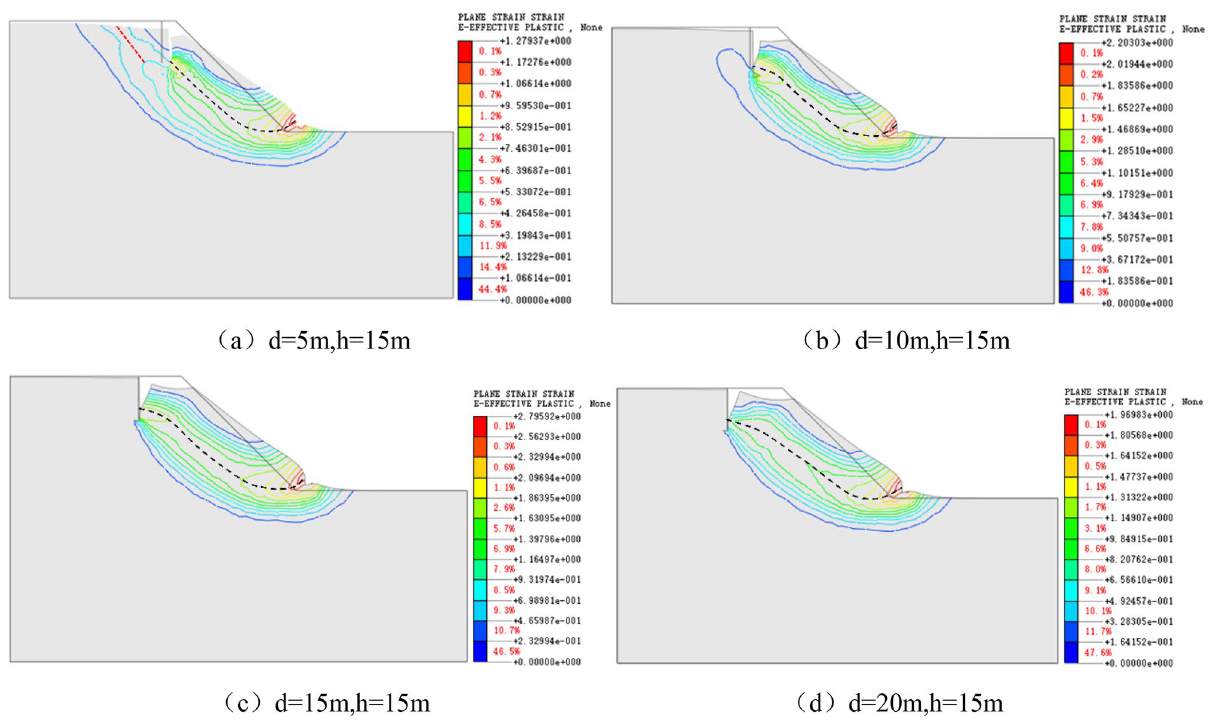
Figure 7. Cloud chart of the plastic zone and sliding surface with vertical joints h = 15 m and d = 5–20 As displayed in Fig. 6, firstly, the cloud chart with the contour line of the plastic zone at the bottom of the vertical joints are denser, which indicates that the stress concentration phenomenon occurs here and the actual slope is subjected to more considerable tensile stresses; secondly, the failure surface of the slope consists of two parts, the tensile zone at the top of the slope (red dashed line) and the tensile zone at the bottom of vertical joints + shear zone at the bottom of vertical joints (black dashed line); thirdly, with the increase of the length of vertical joints, the influence of vertical joints on the overall sliding surface of the slope gradually improves. When the length of vertical joints is h = 5 m, the sliding surface of the slope is similar to the pure slope model without joints, and the sliding surface does not pass through the bottom of vertical joints. When the length of vertical joints is h = 10–15 m, the failure of the slope starts from the bottom of vertical joints to shear out at the foot of the slope. When the length of vertical joints is h = 20 m, the sliding surface of the slope no longer starts from the bottom of the vertical joints but from the middle and lower part of the vertical joints, which is consistent with the failure results of the soil mechanical experiments (Fig. 4), indicating that there is an extreme value of the influence of the length of vertical joints on the sliding surface. The stress concentration at the bottom of vertical joints reaches the peak when the length of the vertical joint h = 5 m. So the length of the vertical joint h = 15 m has the most significant influence on the stability of the slope, which is identical to the research result that the safety factor is the smallest at h = 15 m, as shown in Fig. 5. Figure 7 exhibits that the sliding range of the slope increases gradually with the enhancement of the slope distance of vertical joints. When the slope distance of vertical joints is d = 10 m, the sliding surface of the slope starts from the bottom of vertical joints and ends at the foot of the slope, and the sliding surface includes the whole vertical joint surface. When the slope distance of vertical joints exceeds 10 m, the sliding surface no longer starts from the bottom of vertical joints but the middle and lower part of vertical joints, which means that when d = 10 m and h = 15 m, the deterioration of slope caused by vertical joints reaches the maximum. Shear fracture characteristics of the back edge of sliding surface of the slope with vertical joints. Soil mechanical experiments and numerical simulations both manifest that the failure mode of soil with vertical joints is "tension + shear fracture". The soil mechanical experiments show that sliding failure can occur along the joints when the dip angle of diagonal joints is β = 45°–70°, and the dip angle of shear fracture of vertical joints is 41°–68°. Some models are designed to verify the reasonableness of the unit study results of the soil mechanical experiments and further investigate the characteristics of unstable sliding motion of slopes containing vertical joints. Meanwhile, the dominant failure inclination of the back edge of the slope can reveal the disaster-causing mechanism. The model parameters are presented below: lengths of vertical joints h = 15 m; the slope distance d = 10 m; the diagonal joints with the length of l = 11.5 m are added at the bottom of the vertical joint, and the included angles of the diagonal joints with horizontal direction β are 30°, 45°, 57°, 65° respectively. Figure 8 illustrates the main sliding surface of each model and the cloud chart with the contour line of the plastic zone. The sliding surfaces in Fig. 8 are summarized as shown in Fig. 9.